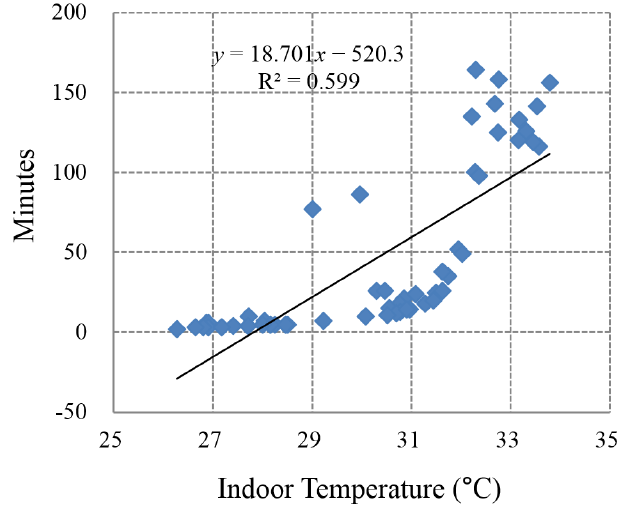
Figure 8. Relationship between the indoor temperature ( TEMP IN ) and the required minutes for restoring from the current temperature to the normal set-point temperature.